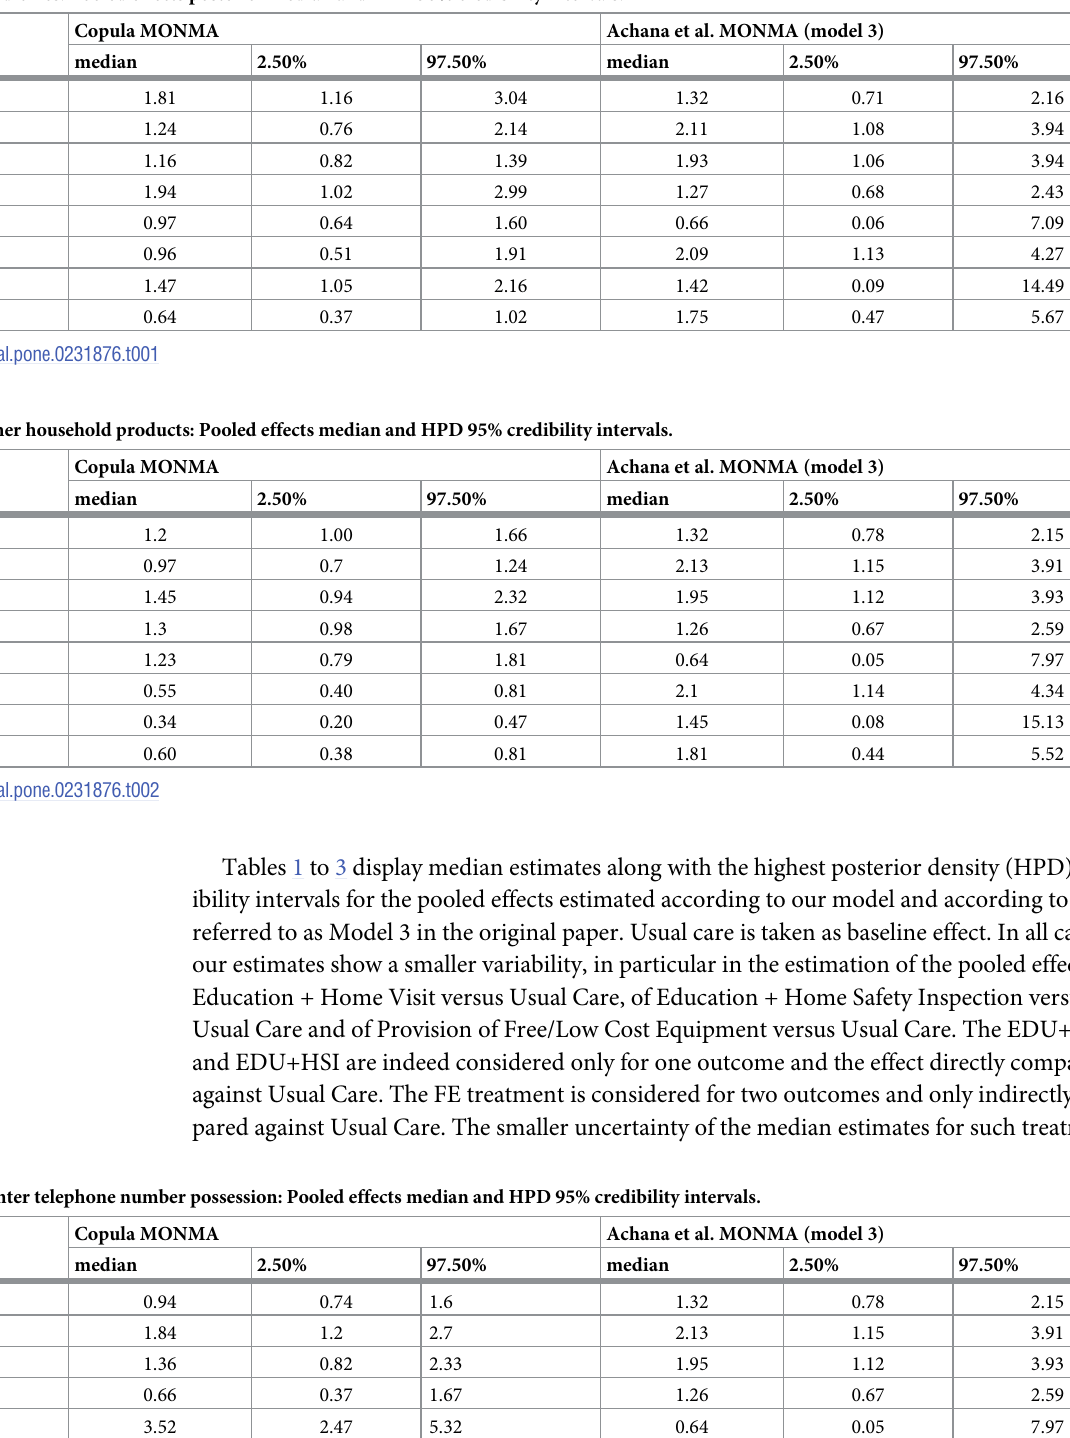
Table 1. Safe storage of medicines: Pooled effects posterior median and HPD 95% credibility intervals.